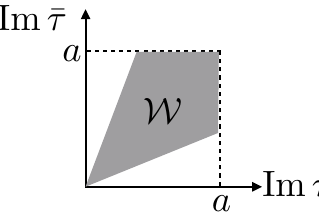
Figure 6 . The region relevant for the second application of Vladimirov’s W